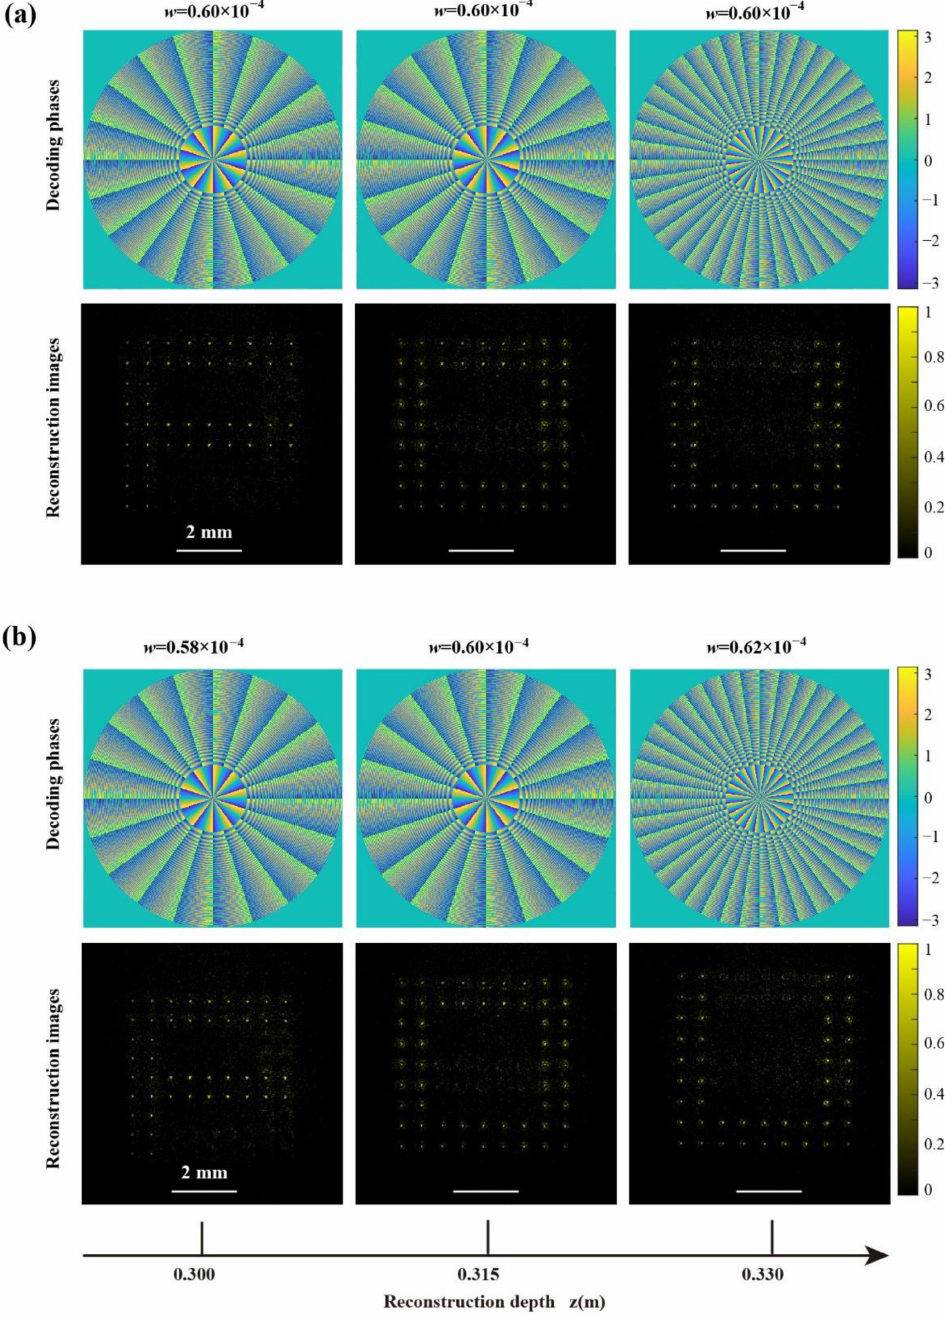
Figure 6. Decoding the OAM multiplexing hologram by BAL method. ( a ) Reconstruction results at a distance of 0.315 m. ( b ) Reconstruction results at different distances by adjusting BAL